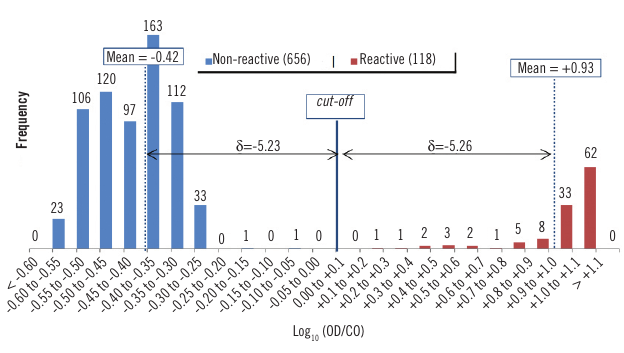
figuRE – Distribution of log (OD/CO) for DBS HIV reactive and non-reactive samples 10 OD: optical density; CO: cut-off; δ : delta value; DBS: dried blood spot; HIV: human immunodeficiency virus.